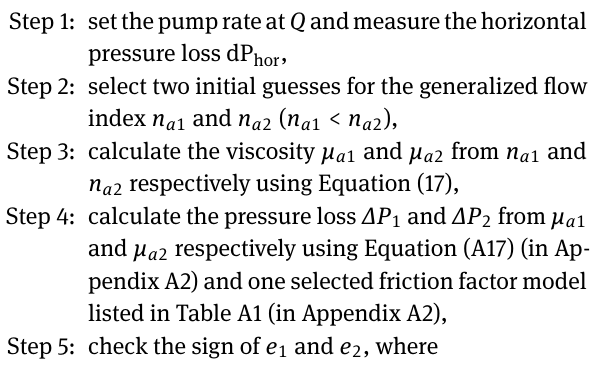
Algorithm 2 (Shooting method for calculating µ a )